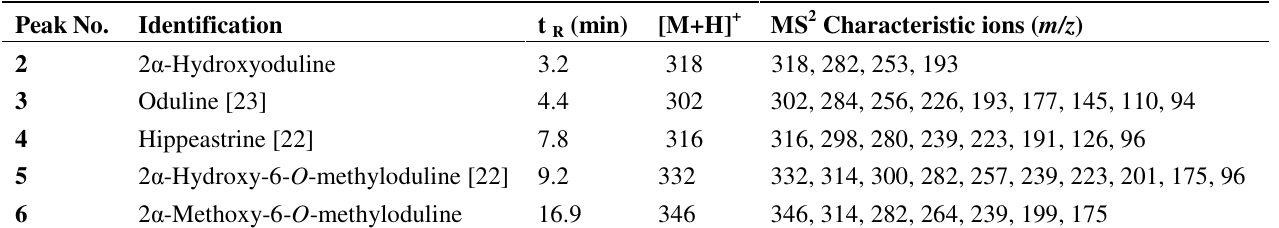
Table 2. Alkaloids in the extract of Lycoris aurea